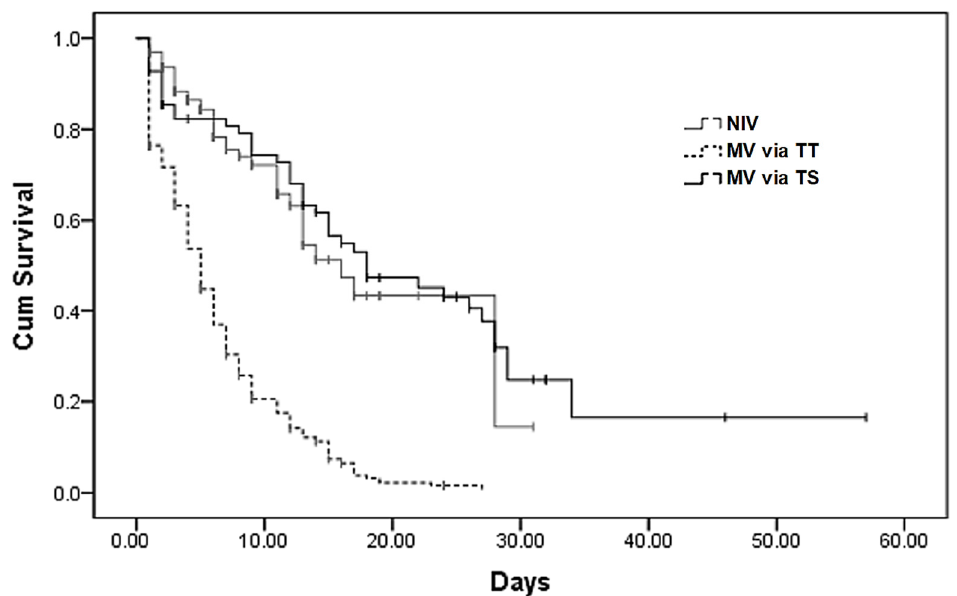
Figure 2. Kaplan–Meier survival plots for the approach of mechanical ventilation. Legend. Pairwise log rank comparisons of survival showed statistically significant differences in survival between TS and TT, as well as between NIV and TT, p < 0.001. No statistically significant log rank differences in survival were found between NIV and TS, p = 0.905. Abbreviations: NIV—non-invasive ventilation; MV—mechanical ventilation; TT—invasive mechanical ventilation with tracheal tube; TS—invasive mechanical ventilation with tracheostomy.